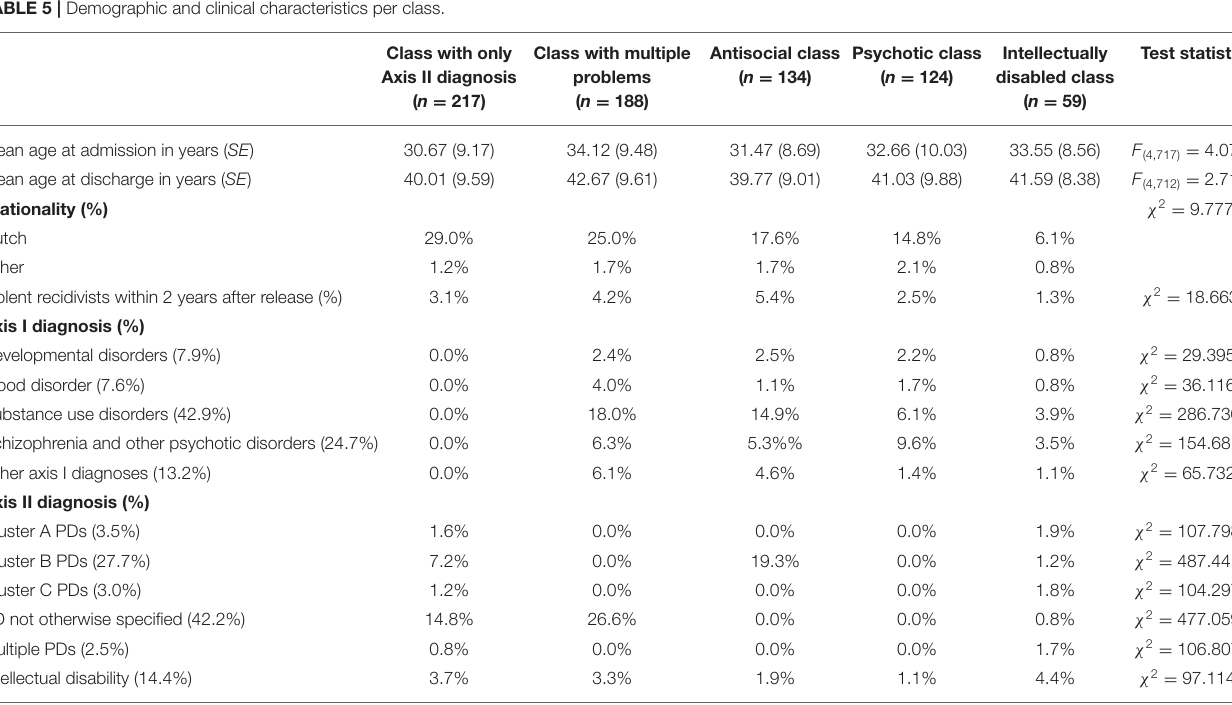
TABLE 5 | Demographic and clinical characteristics per